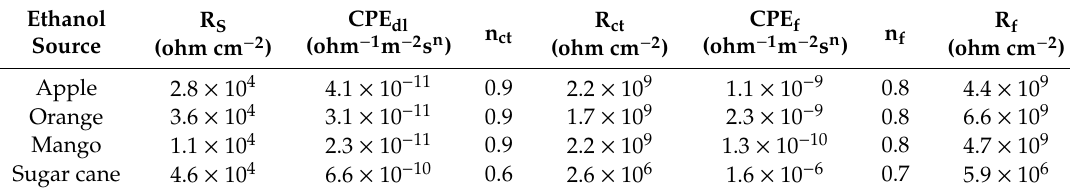
Figure 11. Electric circuits used to simulate EIS data for Al in ethanol–gasoline blends when the corrosion process is under ( a ) cage transfer and ( b ) adsorption/desorption control. Table 2. Parameters used to fit the EIS data for Al corroding in the different ethanol–gasoline blends after 7 days of exposure.